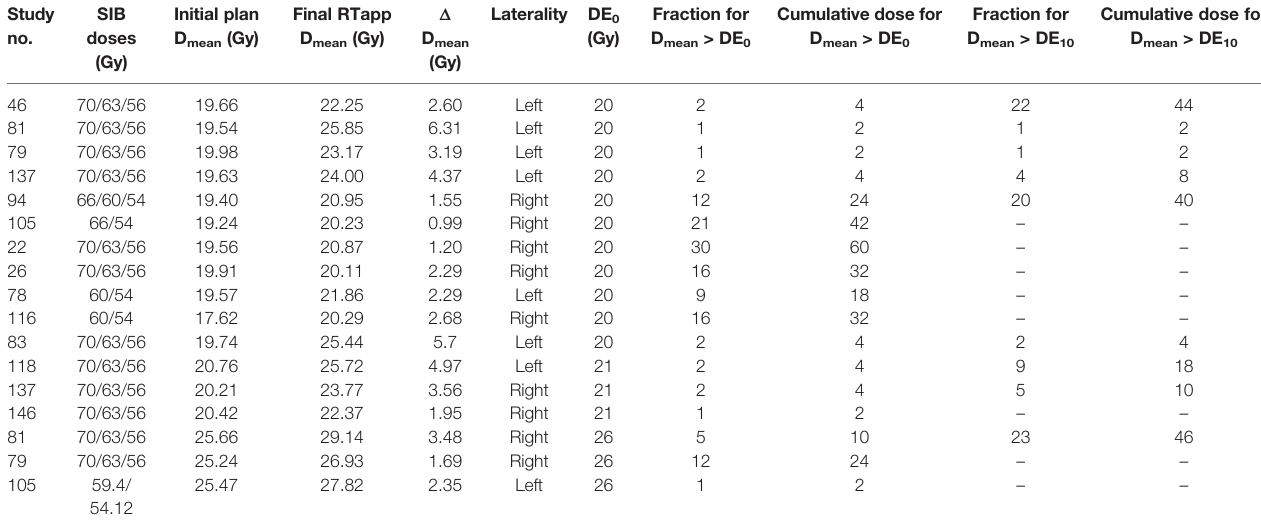
TABLE 5 | Parotid glands D mean violations of the warning dose thresholds (DE 0 ) and of the 10% dosimetric endpoints (DE 10 ) for triggering adaptation. Study